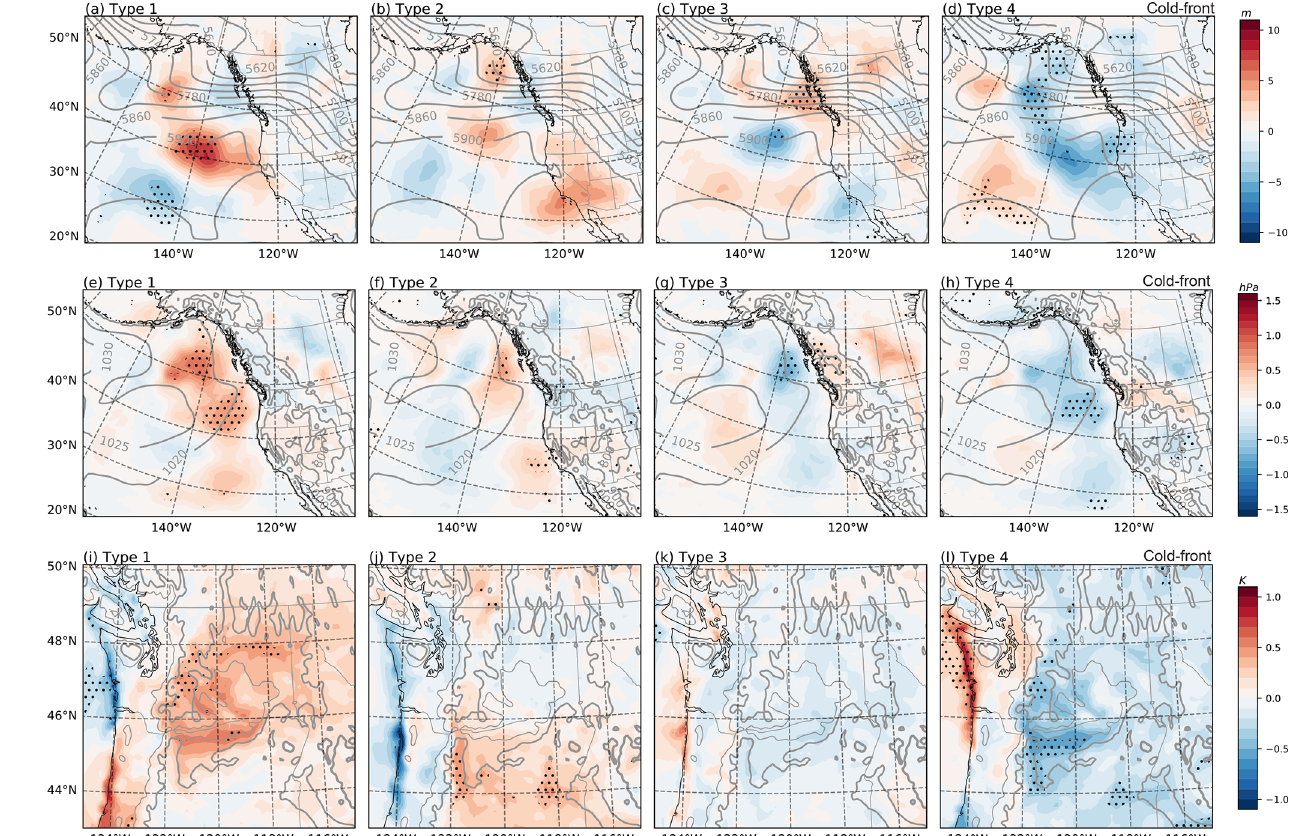
Figure 9. The same as Fig. 6 but for the cold-front